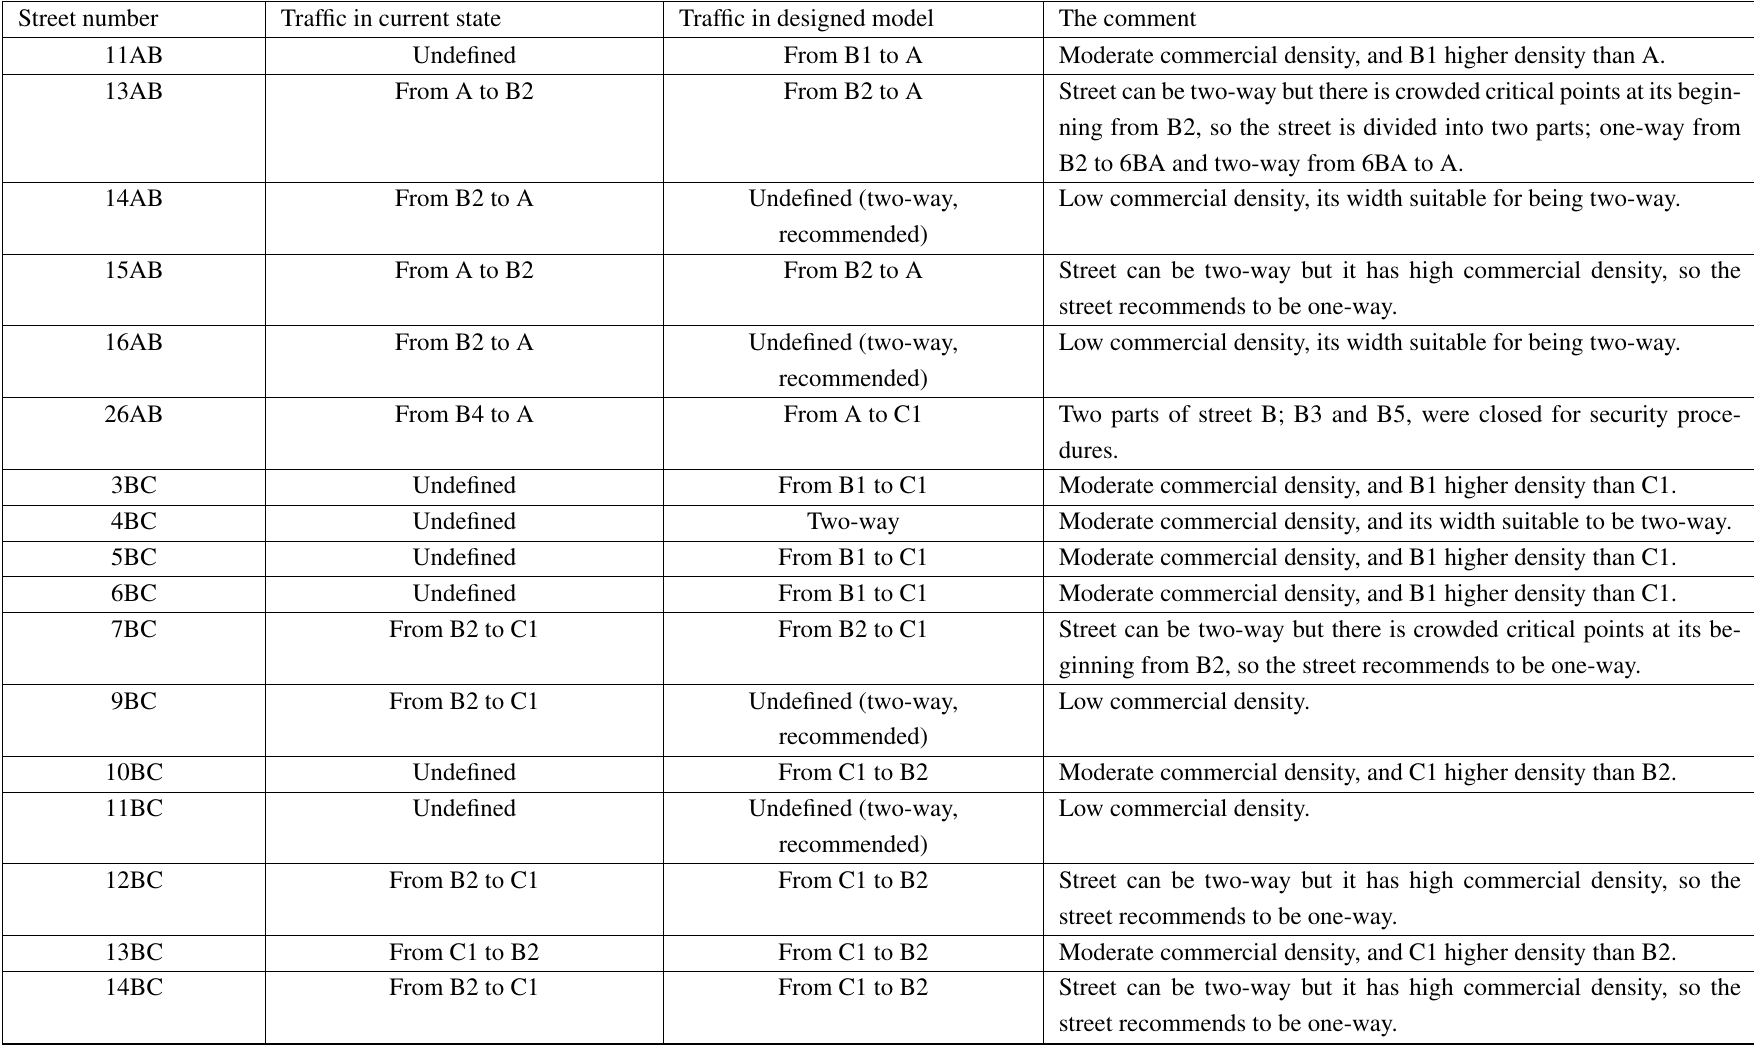
Table 5. The comparsion between traffic in current state and designed